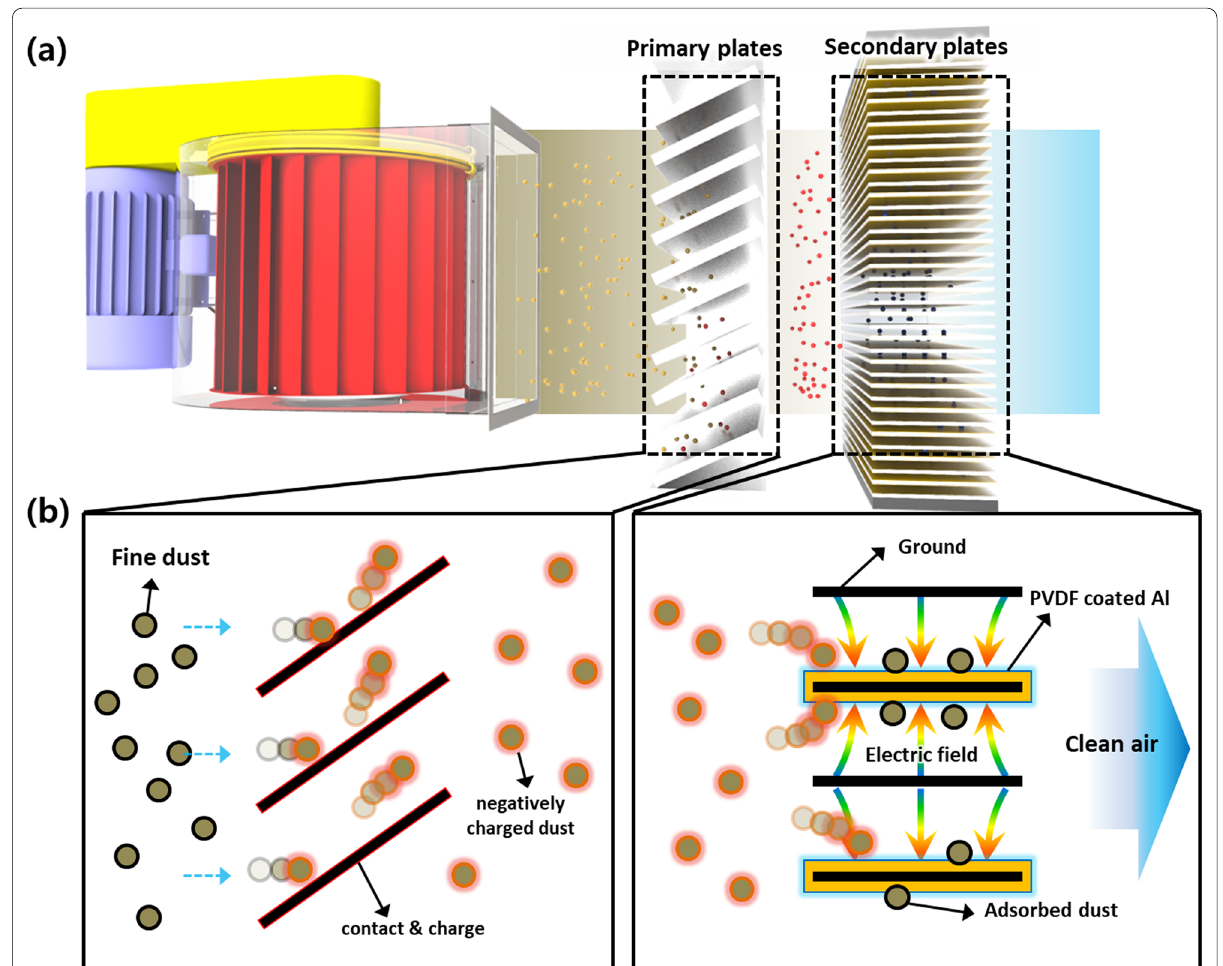
Fig. 4 Schematically described structure a working mechanism of the fine dust filtration system. b Illustrations of the TE filter in the fine dust filtration system. It consists of a bare Al plate charge supplying negative Al electrodes and integrated positive (PVDF‑coated Al)/ground (Al) electrodes. In charge supplying part, fine dust contact with the charge supplying Al electrode, and the fine dust negatively charged. In the dust collecting part, the negatively charged fine dust is attracted to the positive electrode by the Coulomb force by the electric field generated between the positive electrode and the ground